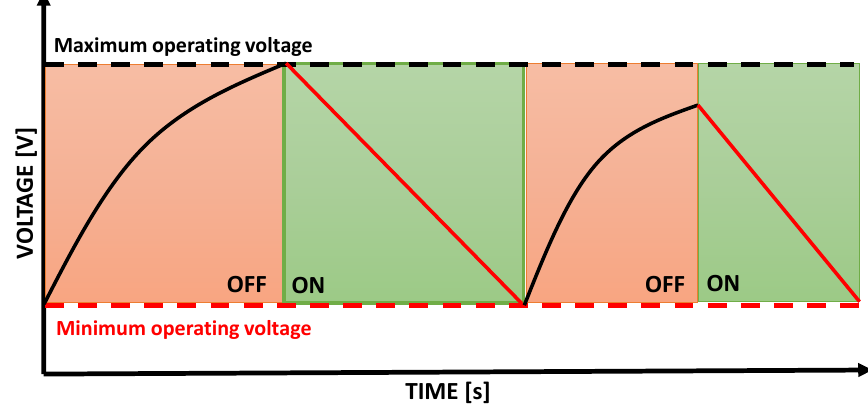
Figure 1. Battery-less intermittent on/off